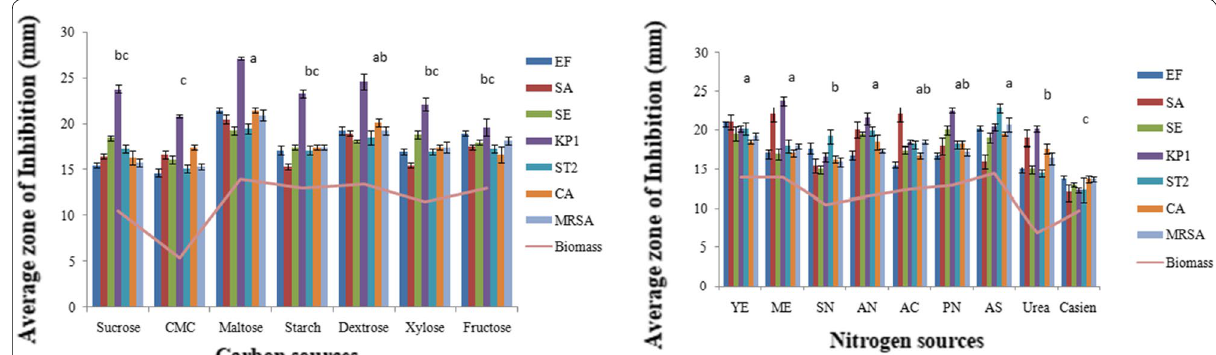
Fig. 6 Effect of different carbon sources and nitrogen sources on antimicrobial activity of C. globosum . EF, Enterococcus faecalis; SA, Staphylococcus aureus ; SE, Staphylococcus epidermidis ; KP1, Klebsiella pneumoniae 1; ST2, Salmonella typhimurium 2; CA, Candida albicans MRSA, Methicillin-resistant Staphylococcus aureus. *Values are given as mean SE. Different letters (a to c) between the columns are significantly different (post hoc tukey Test, ± p 0.05) ≤